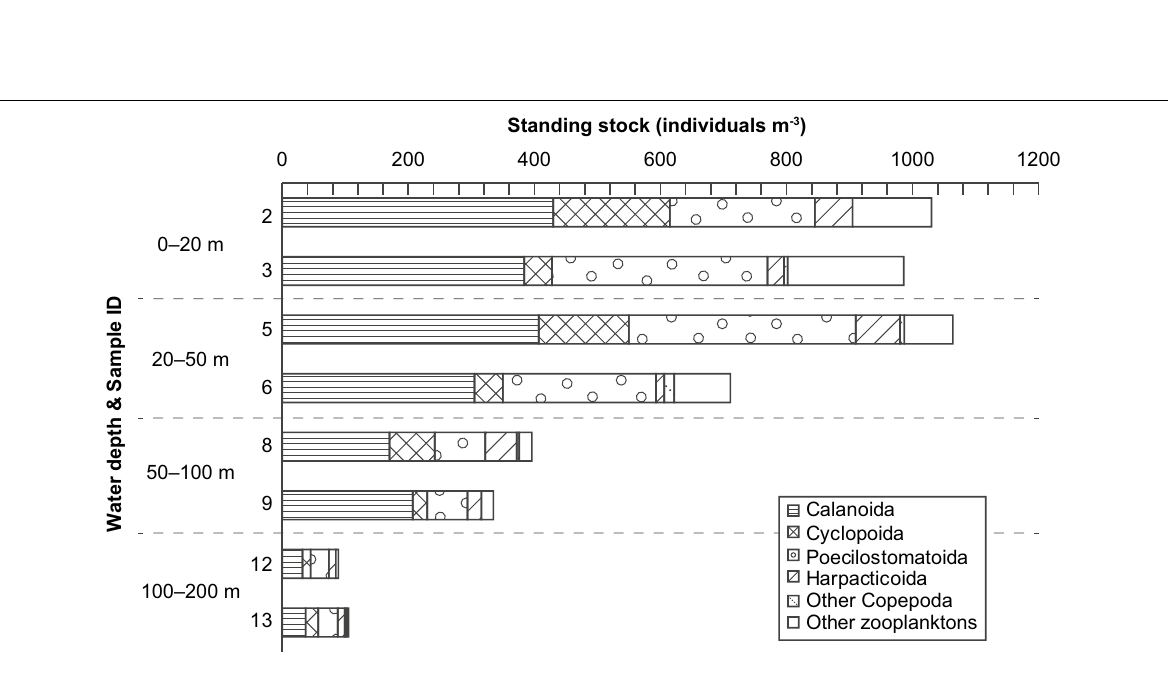
Fig. 3 Standing stocks of living planktonic foraminifers at four depth intervals (0–20, 20–50, 50–100, and 100–200 m; two replicates) in Suruga Bay, Japan